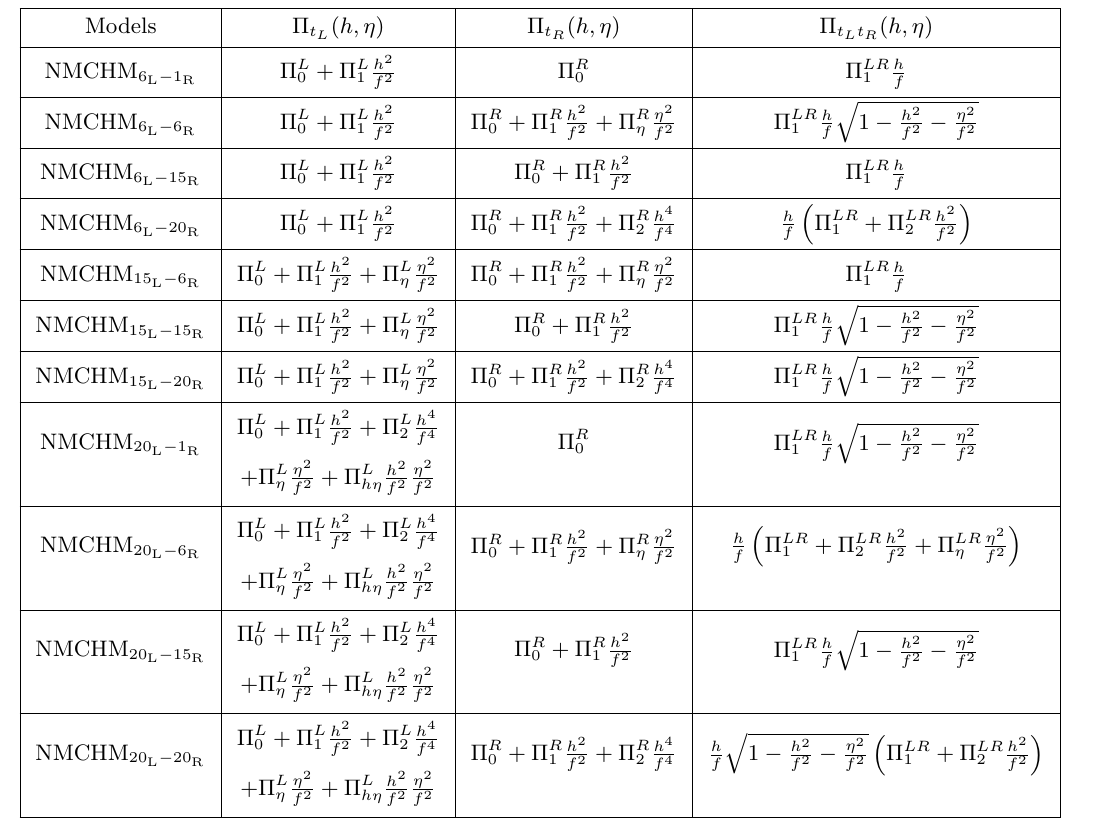
table 4. The NMCHM case is not included in the table because it cannot generate 15 L (cid:0) 1 R a Yukawa term in the Lagrangian.